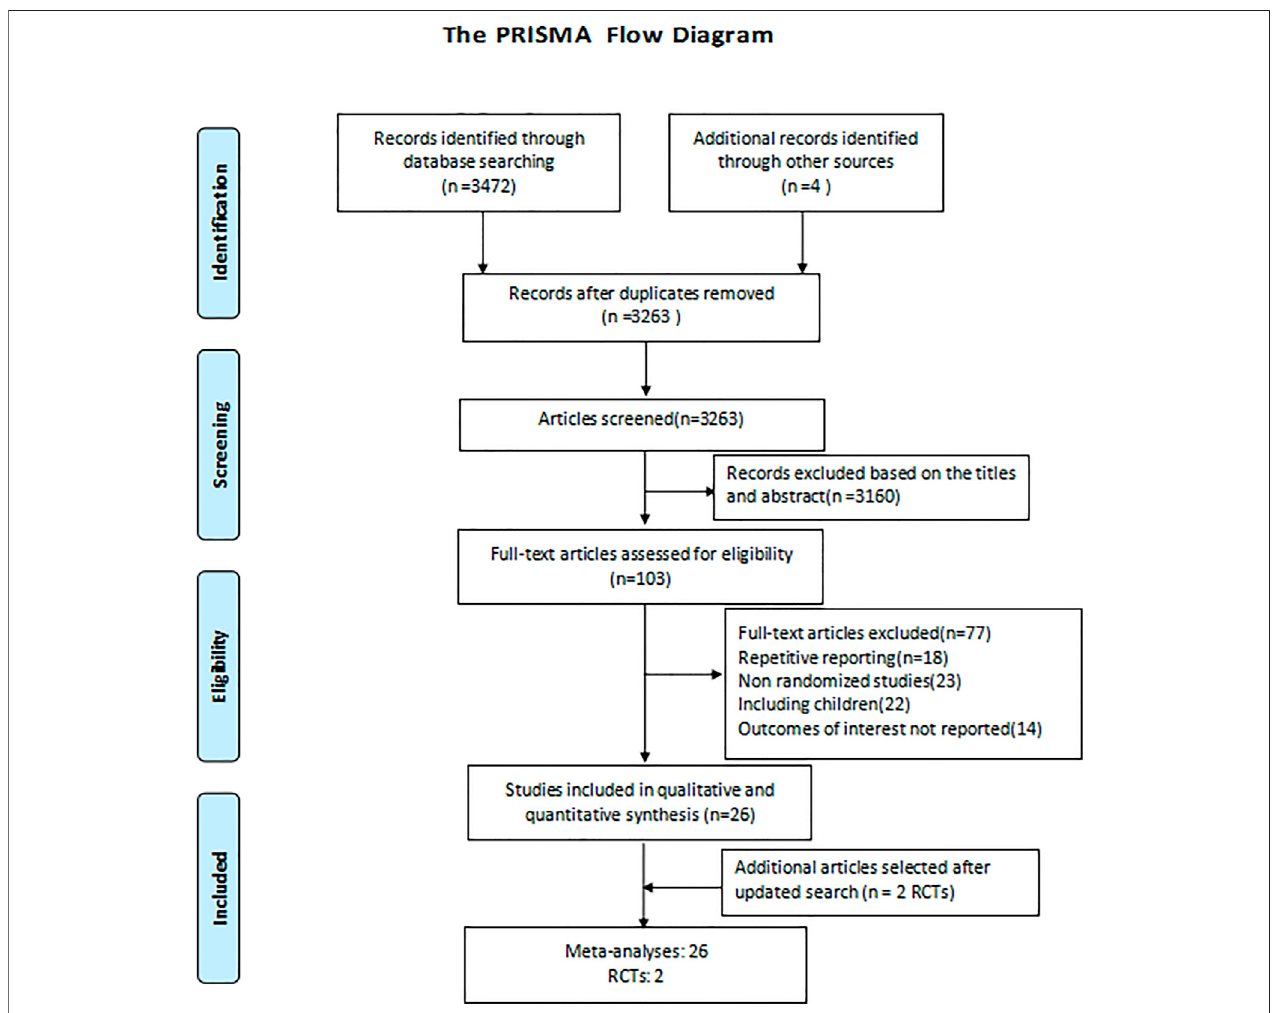
FIGURE 1 | Flow diagram of the selection